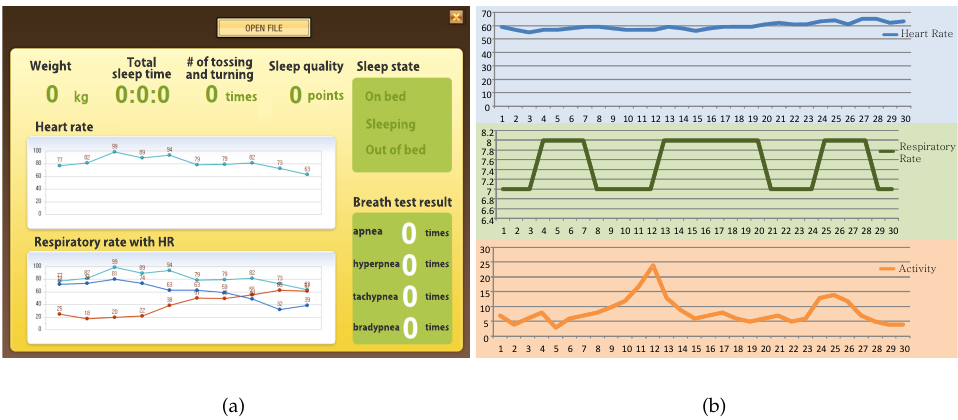
Figure 4. Screenshots of the user interfaces and examples of signals obtained from the sleep quality monitoring system. Screenshots of user interfaces in the sleep quality monitoring system. ( a ) screenshots of user interfaces in the sleep quality monitoring system; ( b ) example signals obtained from the sleep quality monitoring